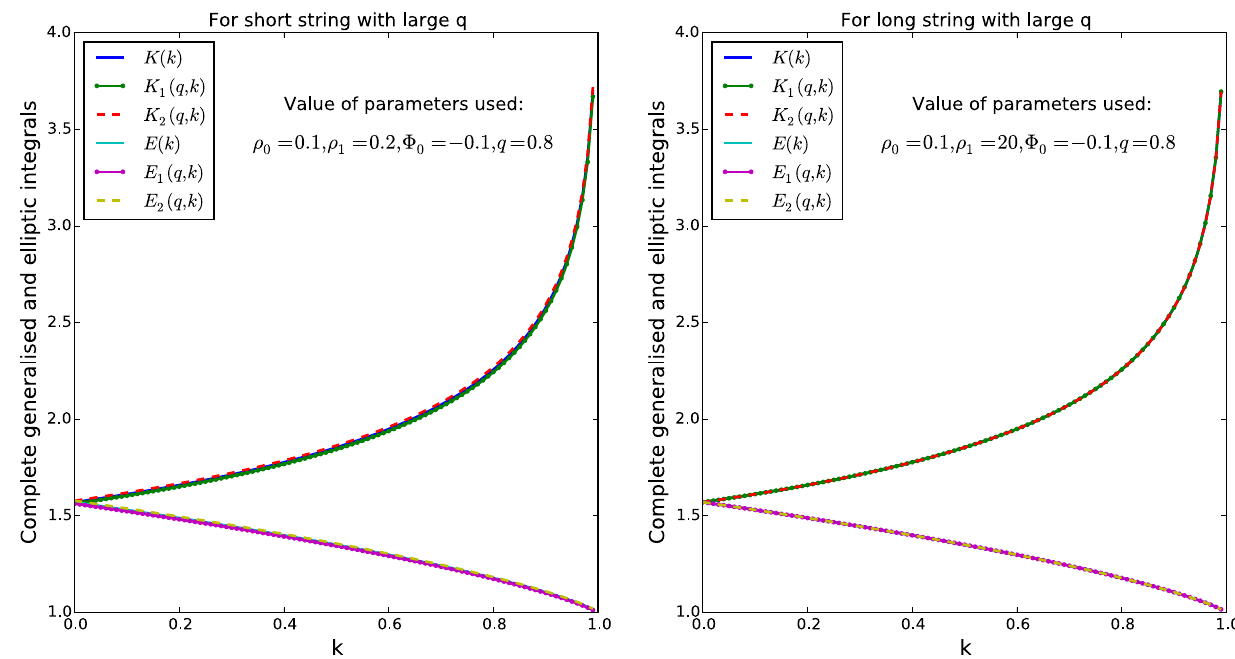
K 2 ( q , k ) and E 1 ( q , k ) , E 2 ( q , k ) areslightlyoffthetrackfromthecurves of K ( k ) and E ( k ) respectively, but for long string limit both of